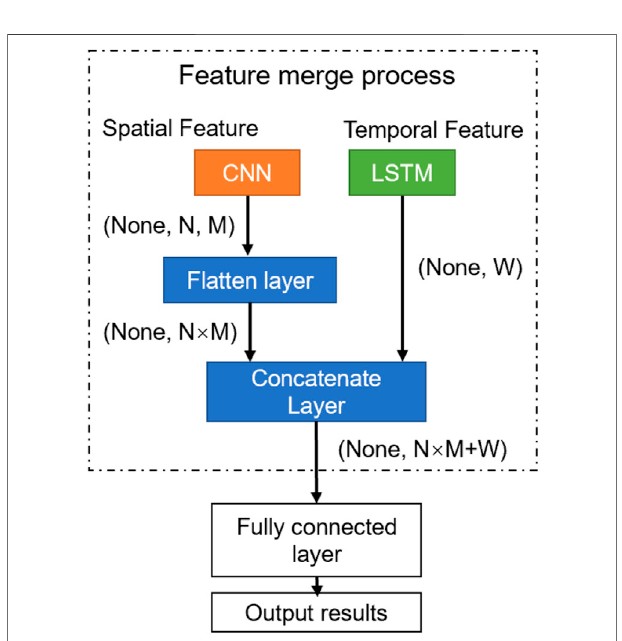
FIGURE 7 | Feature merge